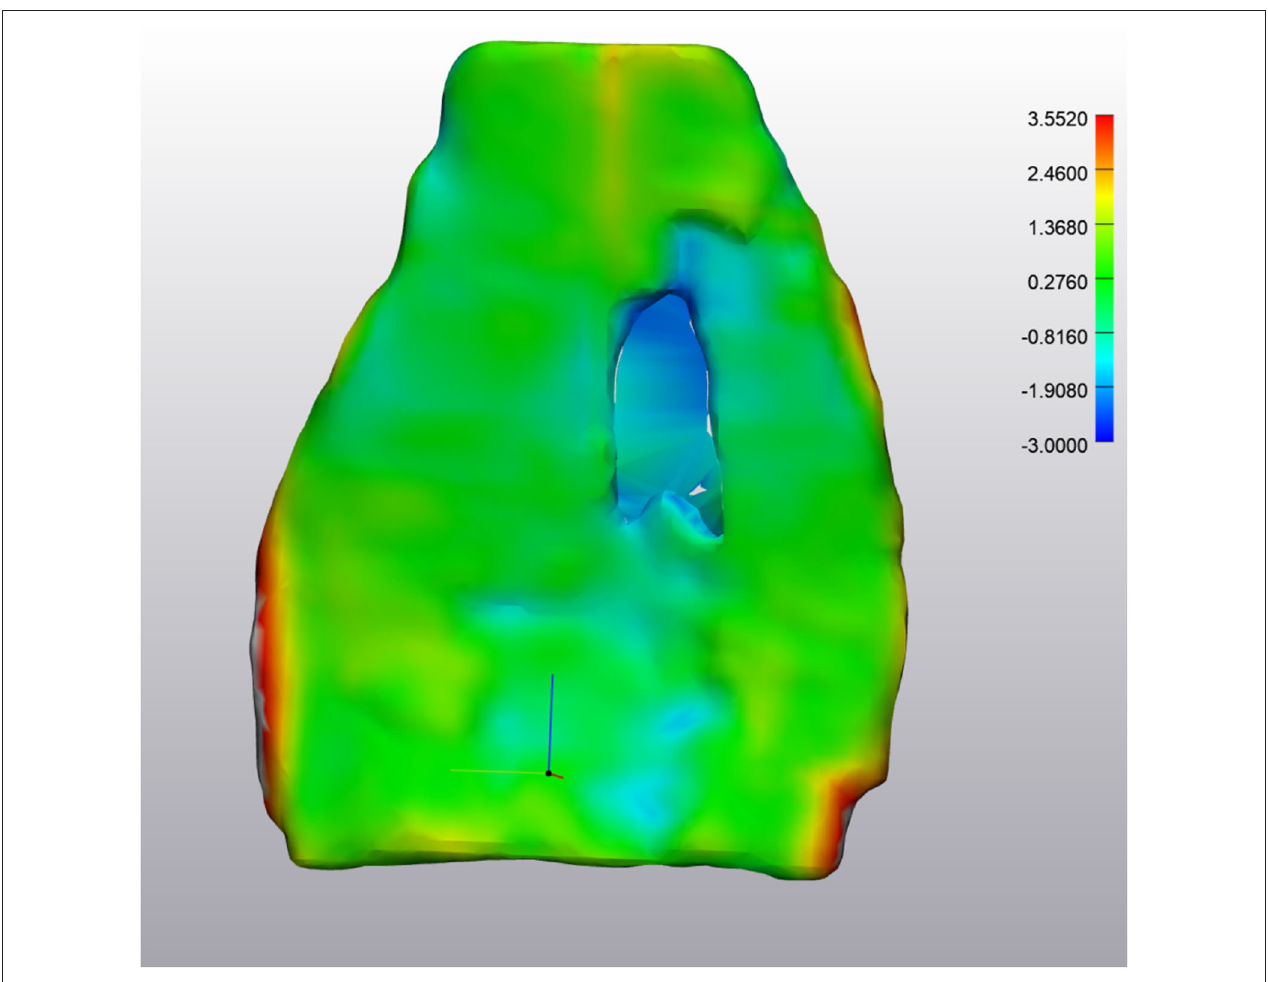
FIGURE 6 | ABNORMAL Deep Digital Flexor Tendon. Analysis of the change in tendon size. The majority of the tendon appears green, indicating the change is minimal ( − 0.81mm − 1.36mm difference). However, the large defect in the center is in excess of − 2.0mm difference. The red portions along the edges are segmentation artifacts due to minor inconsistencies in the segmentation model. Top of the image represents the proximal aspect of the tendon.